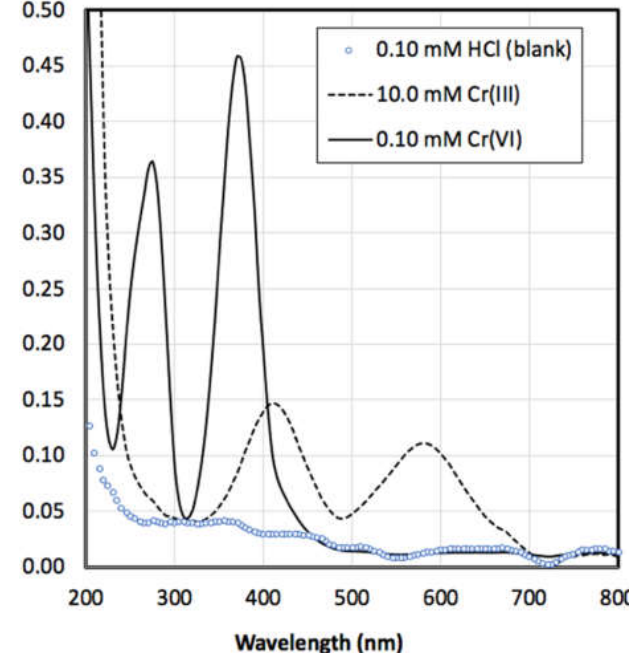
Figure 3. UV–Vis spectra of 0.10 mM HCl, 10.0 mM Cr(III) (as CrCl 3 in 0.10 mM HCl), and 0.10 mM Cr(VI) (as Na 2 CrO 4 ).